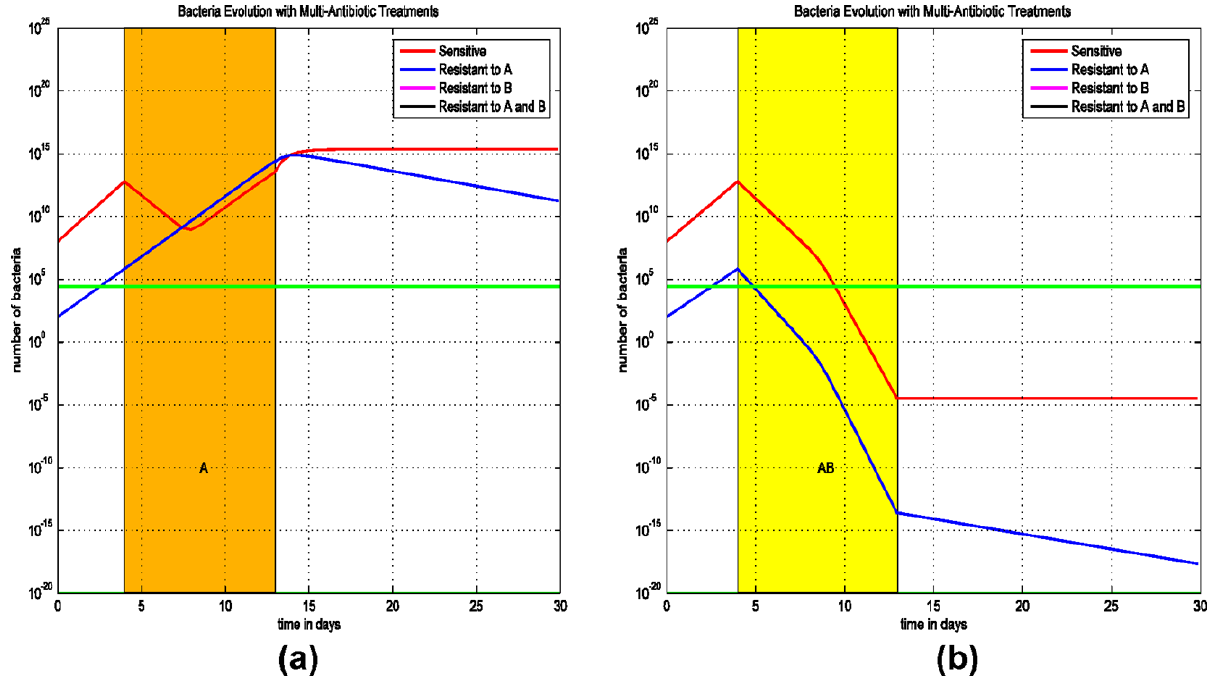
Figure 4. Simulations of Model (3) on multiple antibiotic therapies. In both simulations, treatment starts at the 4 th day after the infection and lasts for 9 days. (a) If antibiotic A fails in the first therapy, then a second treatment with antibiotic B has to be administrated to prevent the infection. (b) A combination of both antibiotics A and B can bring the bacterial level below the threshold and the infection can be prevented.